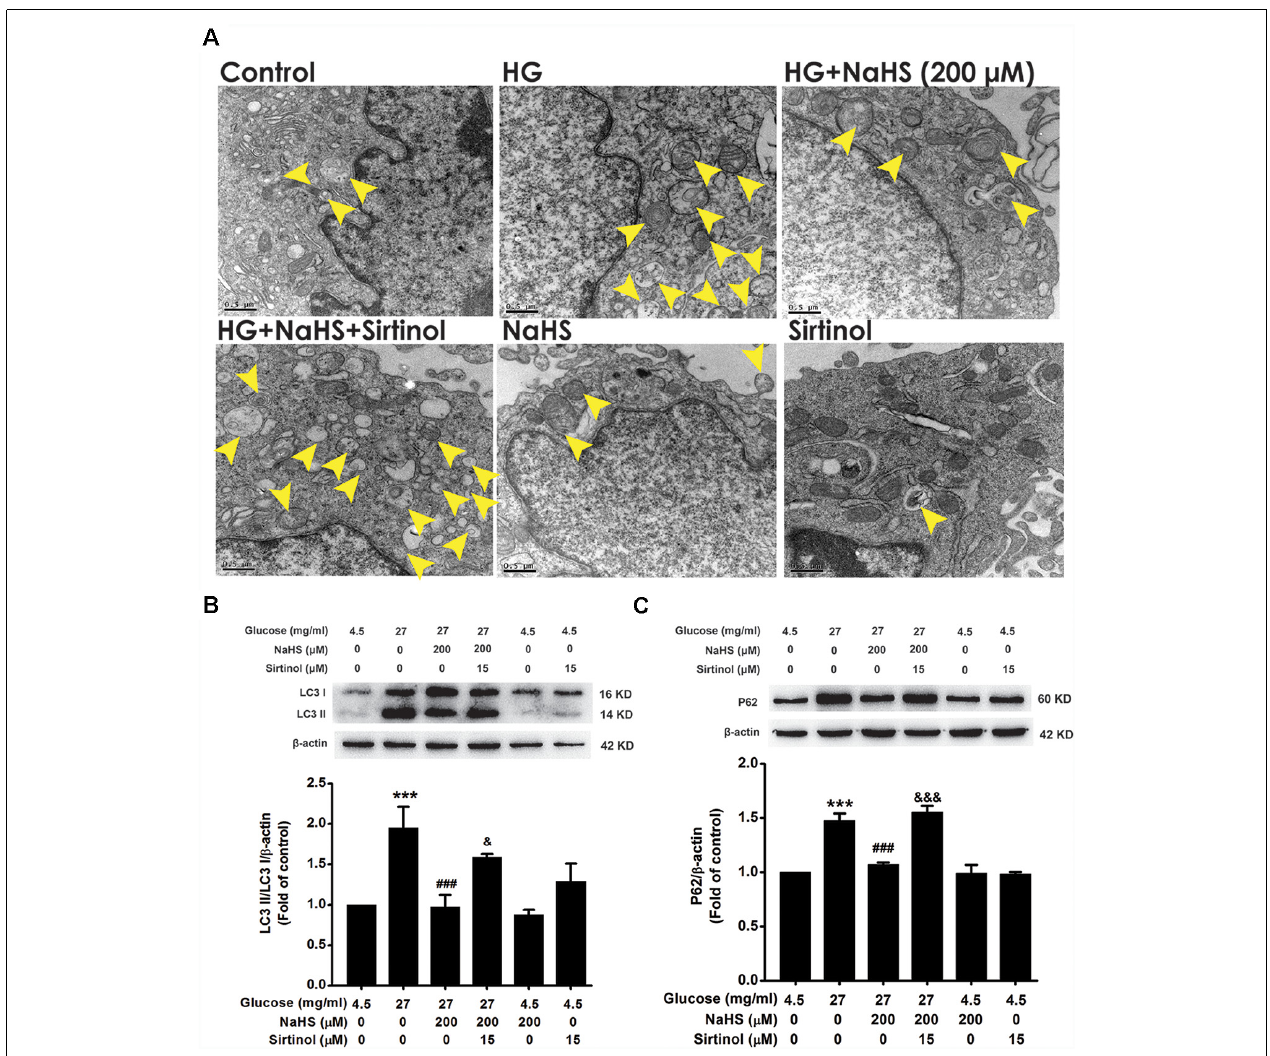
FIGURE 6 | Effect of Sirtinol on the improving effect of H 2 S on autophagic flux in HG-exposed HT22 cells. (A) Representative transmission electron microscope images of HT22 cells showing the change in the number of autophagosome. The yellow arrows indicate autophagosome. (B,C) The expressions of LC3II/LC3I and P62 in HT22 cells were detected by Western blotting. Values were expressed as the mean ± SEM, n = 3. ∗∗∗ P < 0.001, vs. control group; ### P < 0.001, vs. HG-treated alone group. & P < 0.05, &&& P < 0.001, vs. co-treated with NaHS and HG